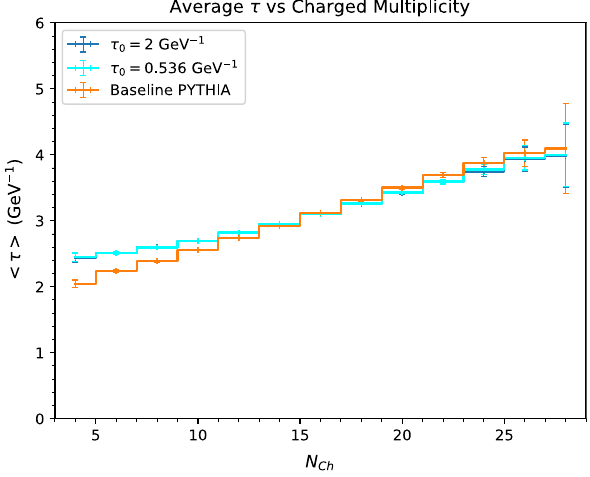
Fig. 6 Variation in average τ with charged multiplicity for our model (blue) and baseline PYTHIA